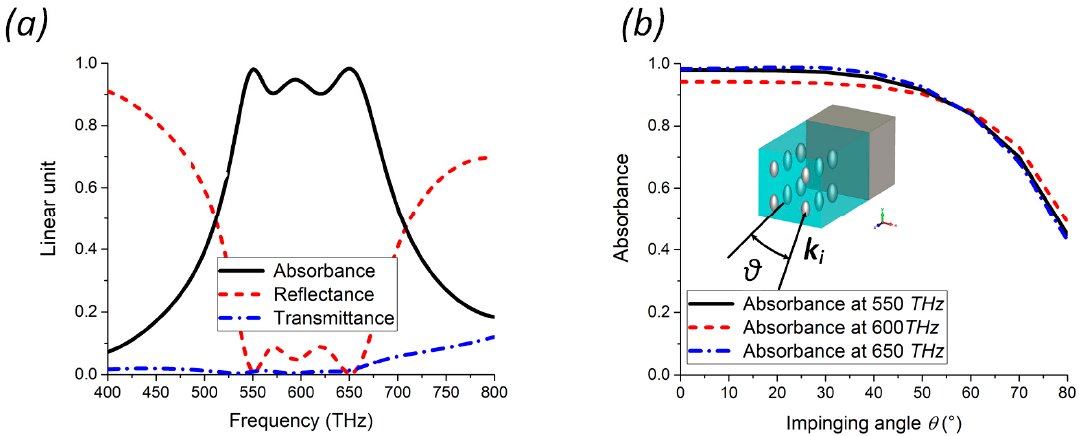
Figure 5. ( a ) The absorbance, reflectance and transmittance (absolute value) of a three-layered CA optical absorber obtained through full-wave simulations; ( b ) the value of the absorbance (absolute value) at three different frequencies as the impinging angle changes.